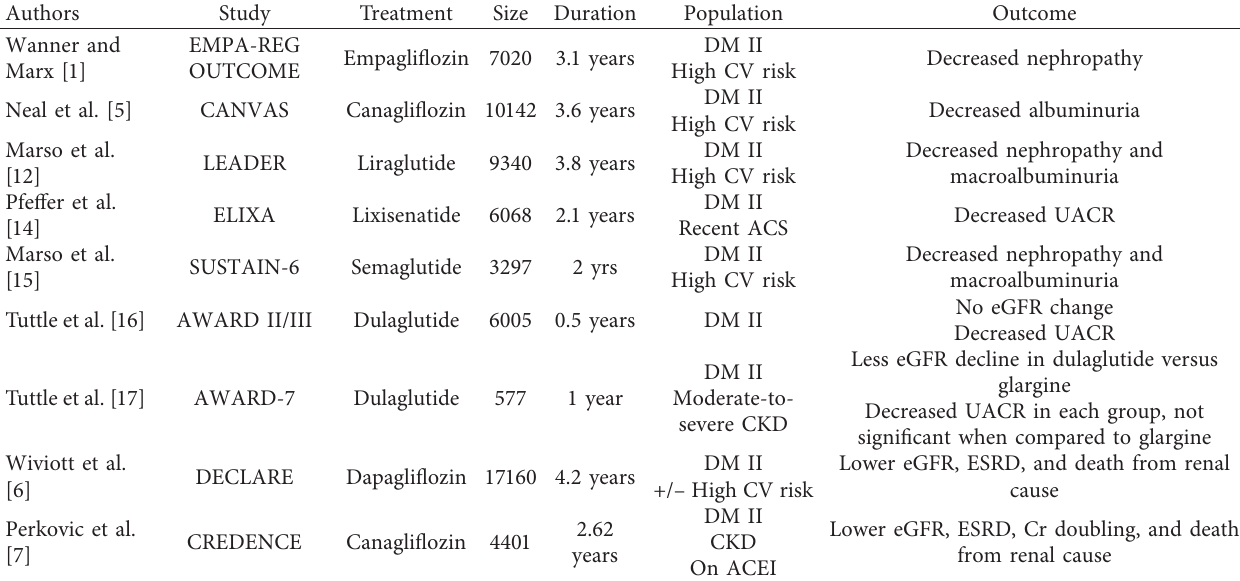
Table 1: Overview of the renal protective studies.